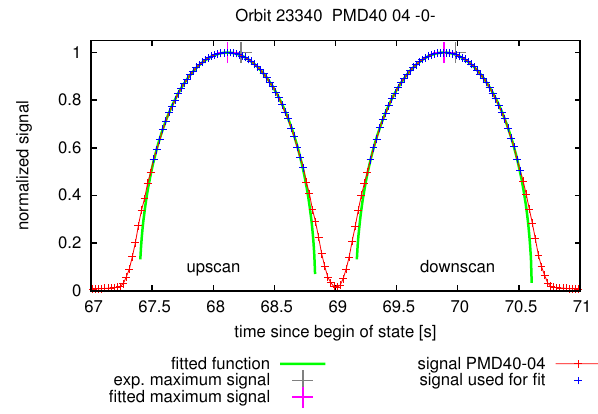
Fig. 5. One up-scan and one down-scan over the solar disk from or- bit 23340 (17 August 2006, first scans above 100km). In red the measured intensities are plotted, the blue crosses mark the used measurements. The green lines show the fitted functions. The large purple cross marks the fitted maximum, the large gray cross the po- sition, where the Sun is expected at that